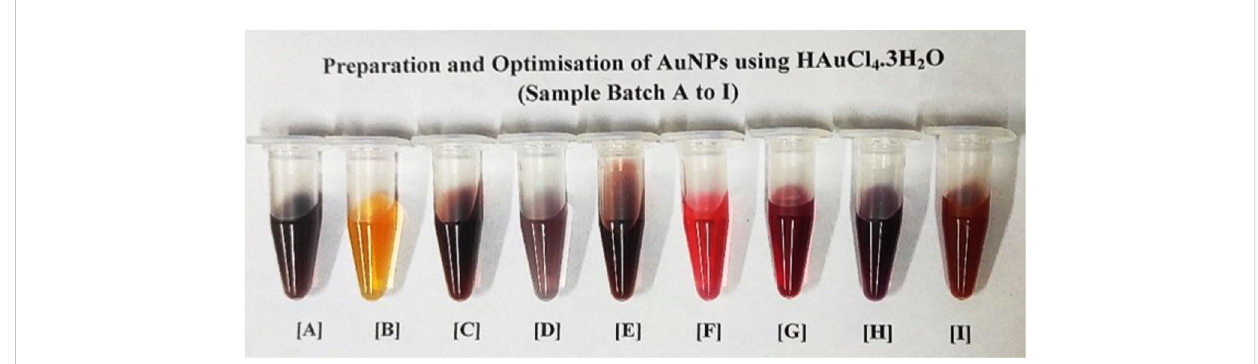
FIGURE 2 Batch-wise (A – I) sample preparation and optimisation of AuNPs at de fi ned molar concentrations of gold precursor as shown in Table 1. Different batches of sol-colloids were obtained having (A) with violet, (B) with yellowish orange, (C) with dark violet, (D) with greyish violet, (E) with dark violet, (F) with crimson red, (G) with dark red, (H) with wine red and (I) with orange red colored nanoparticles. The batch sample ‘ H ’ with ruby-red wine color was standardized in bio-assay development for direct-rapid WC Ag agglutination of Brucella (concentration < 0.1 mM having particle size 50